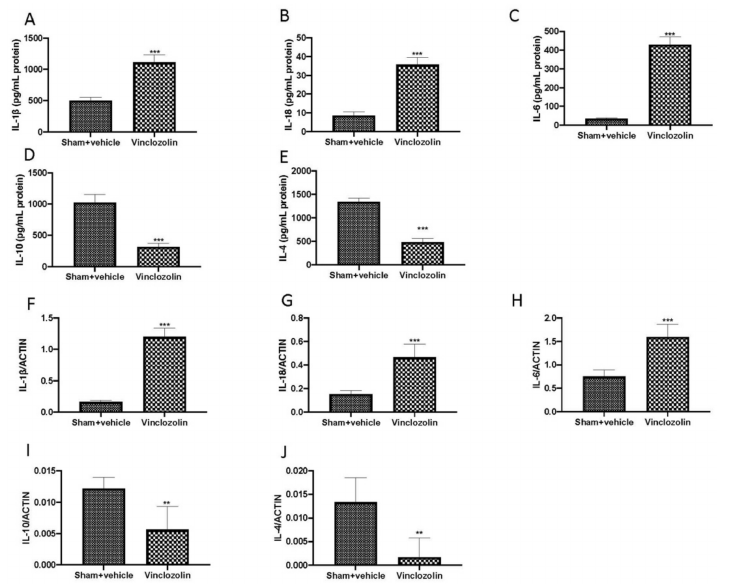
Figure 4. Cytokine analysis after vinclozolin exposure. ELISA kit results for IL-1 β ( A ), IL-18 ( B ), IL-6 ( C ), IL-10 ( D ), and IL-4 ( E ). RT qPCR results for IL-1 β ( F ), IL-18 ( G ), IL-6 ( H ), IL-10 ( I ), and IL-4 ( J ). As shown, after vinclozolin exposure, there was a significant increase in proinflammatory cytokines, as well as a significant decrease in anti-inflammatory cytokines. Values are the means ± SEM of 6 mice for all groups. ** p < 0.01 vs. sham, *** p < 0.001 vs.